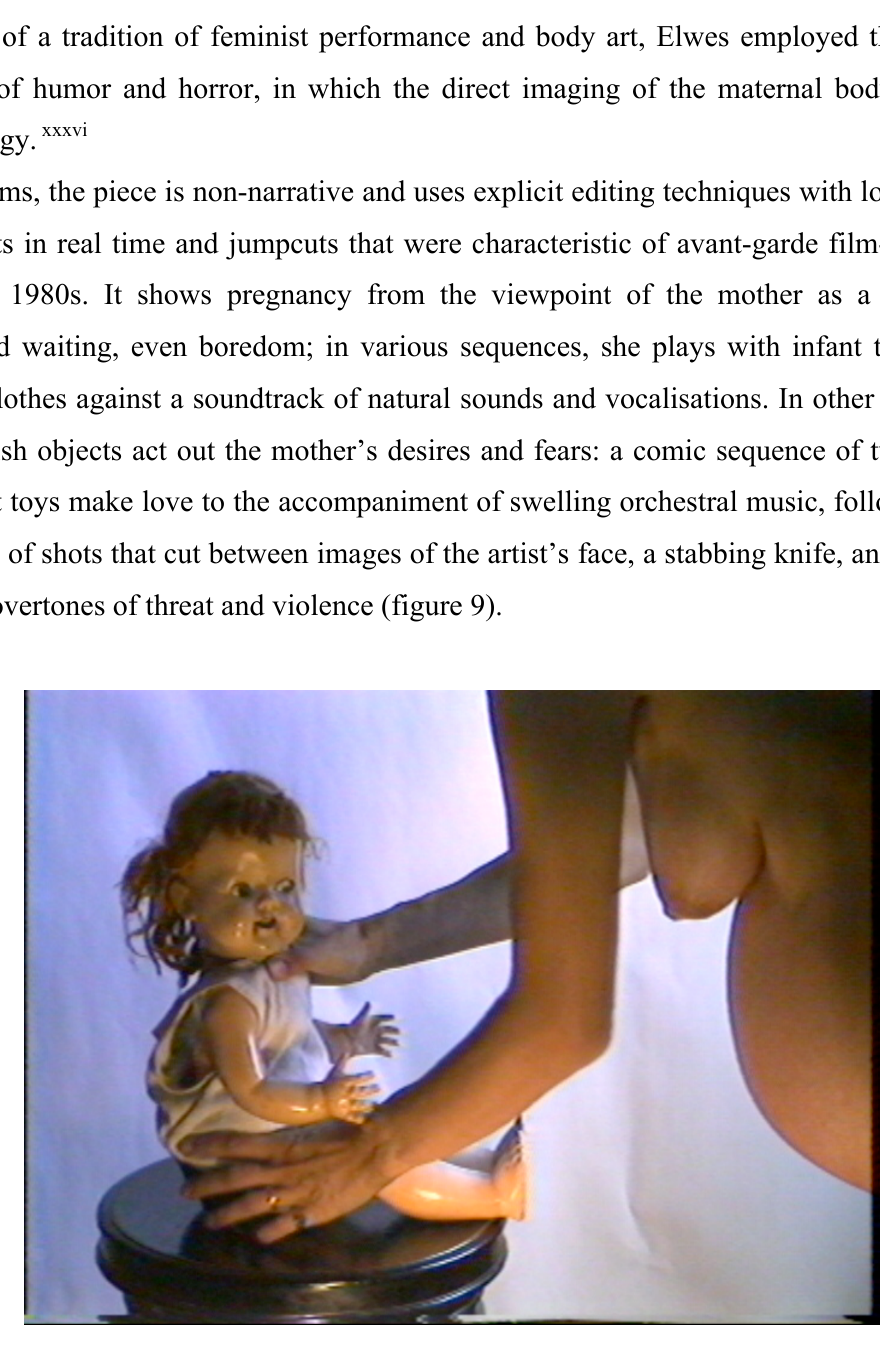
Figure 8: Cate Elwes With Child 1983. Video still